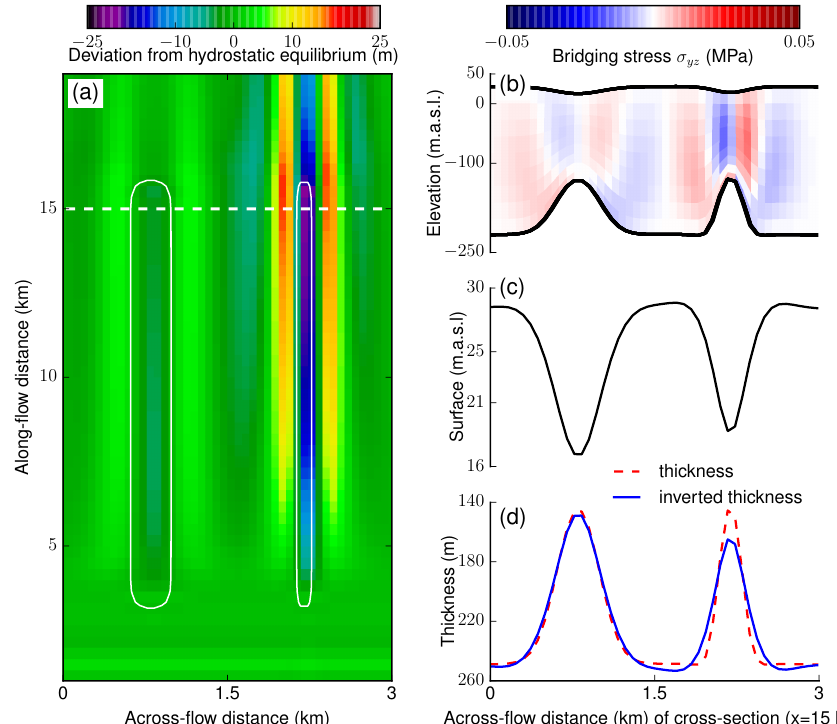
Figure 4. Steady-state results for a laterally unconstrained ice shelf with two channels. The prescribed melt function has the same peak amplitude for both channels but varies in the across-flow width (MS4, Table 1). The deviation from hydrostatic equilibrium is shown in (a) . The white curves mark zones of melting, the dashed line depicts the cross section showing bridging stresses in (b) , the surface in (c) , and ice thickness in (d)